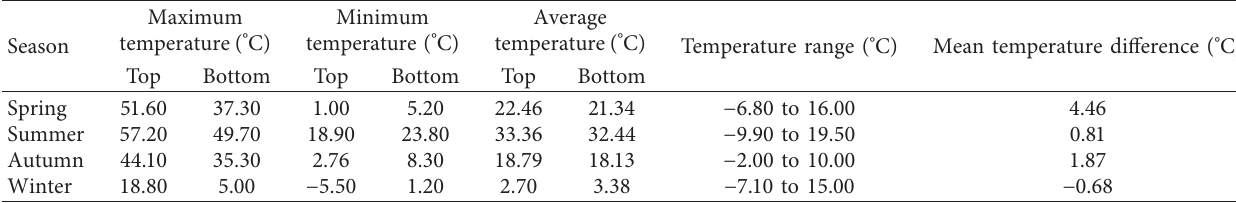
Table 3: Measured temperature and temperature difference between top and bottom of the plate in each season.